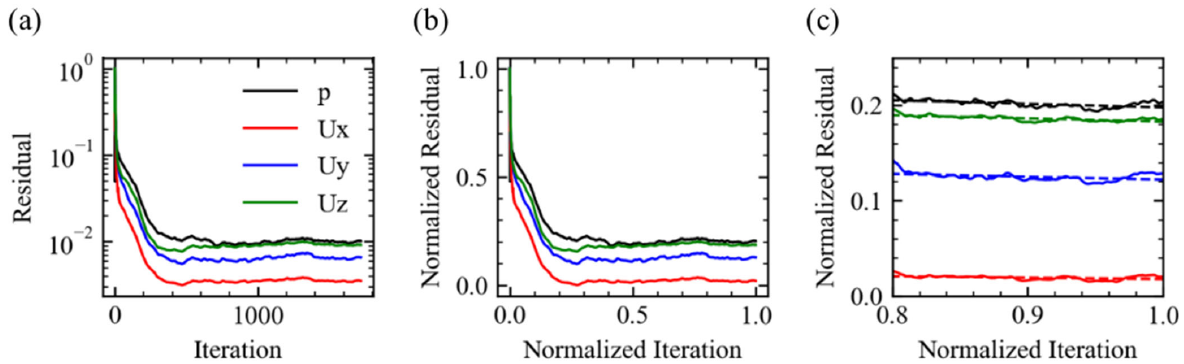
Figure 4. Residual control procedure ( a ) residuals, ( b ) normalized residuals and ( c ) the last 20% of normalized residuals with linear approximations. (S p = − 0.038, S Ux = − 0.015, S Uy = − 0.03, S Uz = − 0.033).